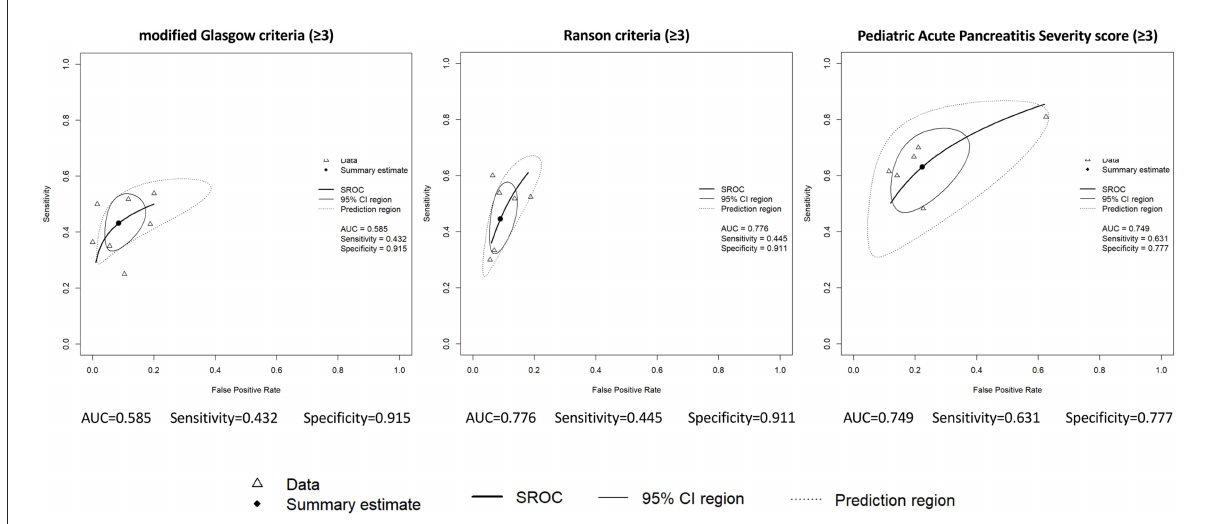
FIGURE2 Hierarchical summary receiver operating characteristic (HSROC) curves. Data are presented for the following predictive score systems: modified Glasgow criteria, Ranson criteria, Pediatric Acute Pancreatitis Severity score. The values used as cut-off for indicating a moderate or severe disease are given in brackets. Triangles represent data obtained from individual studies, rectangles represent the summary estimates, bold solid line the summary receiver operating curve, solid line the 95% CI region, dotted line the prediction region. AUC, area under the curve; CI, confidence interval; SROC, summary receiver operating characteristic